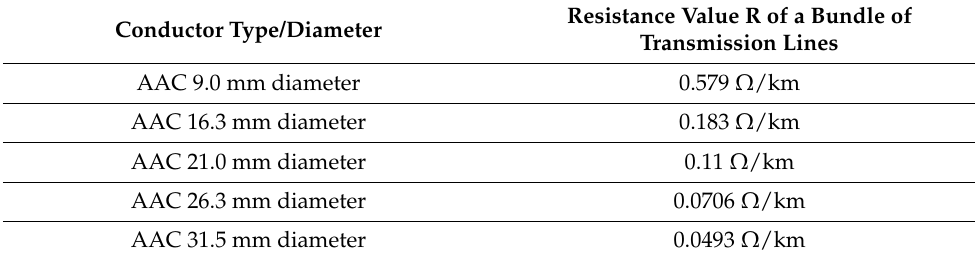
Table 1. Preliminary selection of five candidate